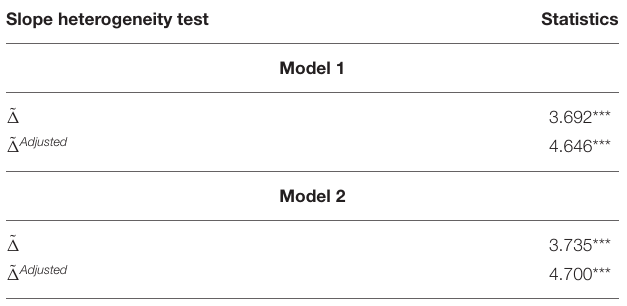
TABLE 2 | Slope heterogeneity.